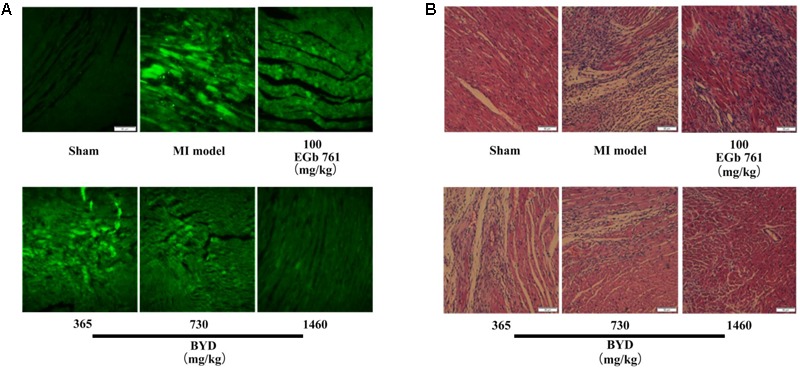
Histopathology and TUNEL assay. (A) Representative photomicrographs of cardiac tissue sections stained with H&E; (B) TUNEL assay of apoptotic cardiomyocytes after MI with BYD treatment; 200 × magnification.